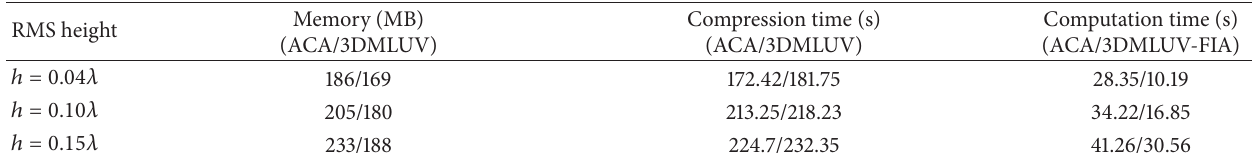
Table 1: Computation time and memory requirement.